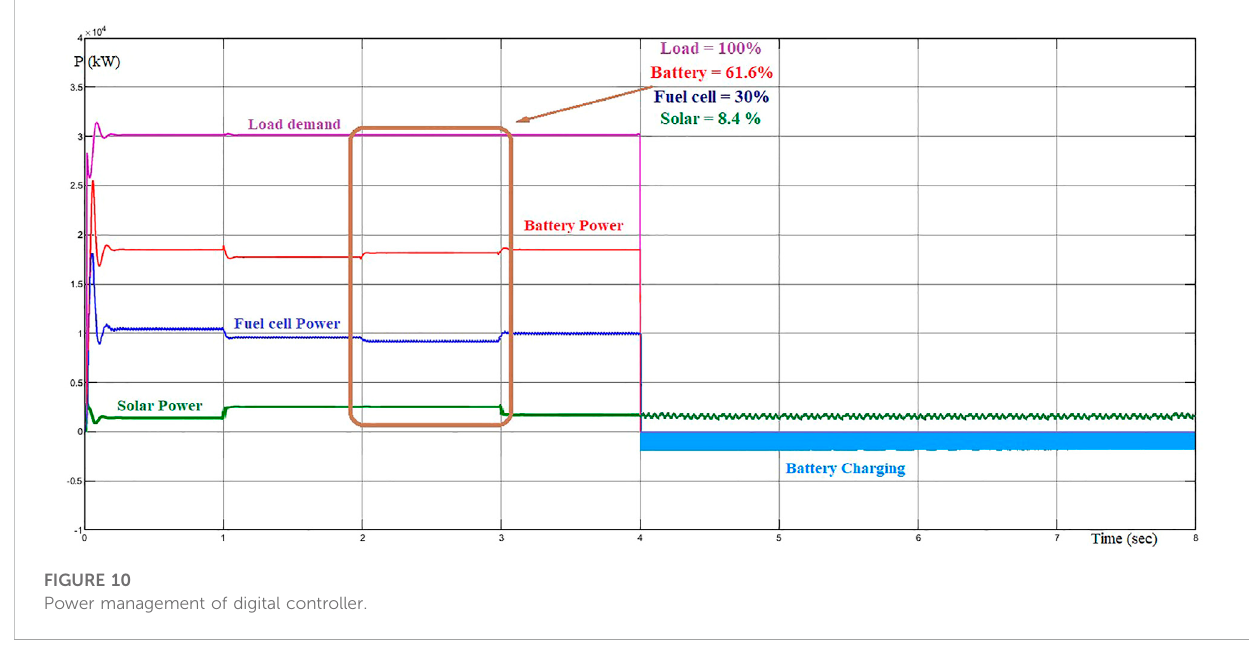
FIGURE 10 Power management of digital controller.